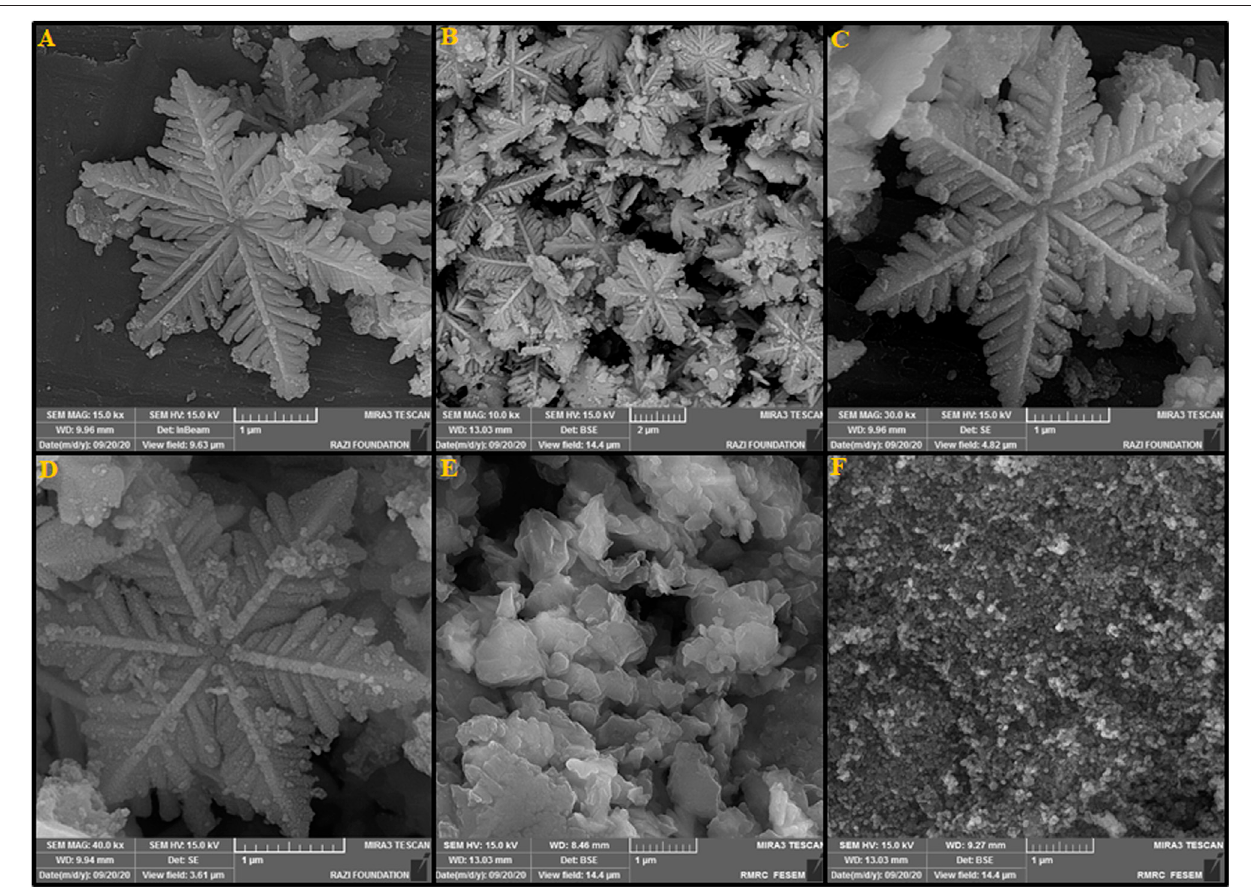
FIGURE 2 | FESEM images of the La 2 O 3 NP@SF-L Cu 2 S NS composite with different La 2 O 3 loading amounts: (A) 10 wt% La 2 O 3 , (B – D) 20 wt% La 2 O 3 , and (E) 30 wt% La 2 O 3 . (F) The FESEM image of La 2 O 3